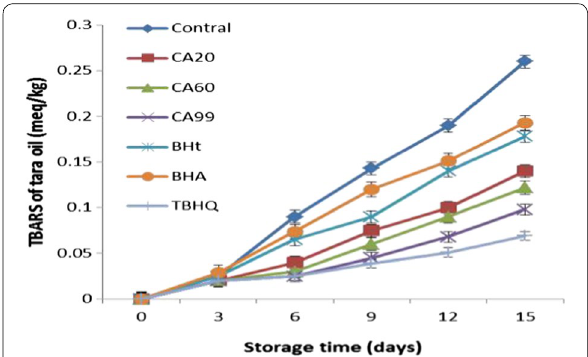
Fig. 3 TBARS results for tara seed oil samples after accelerated oxida‑ tion